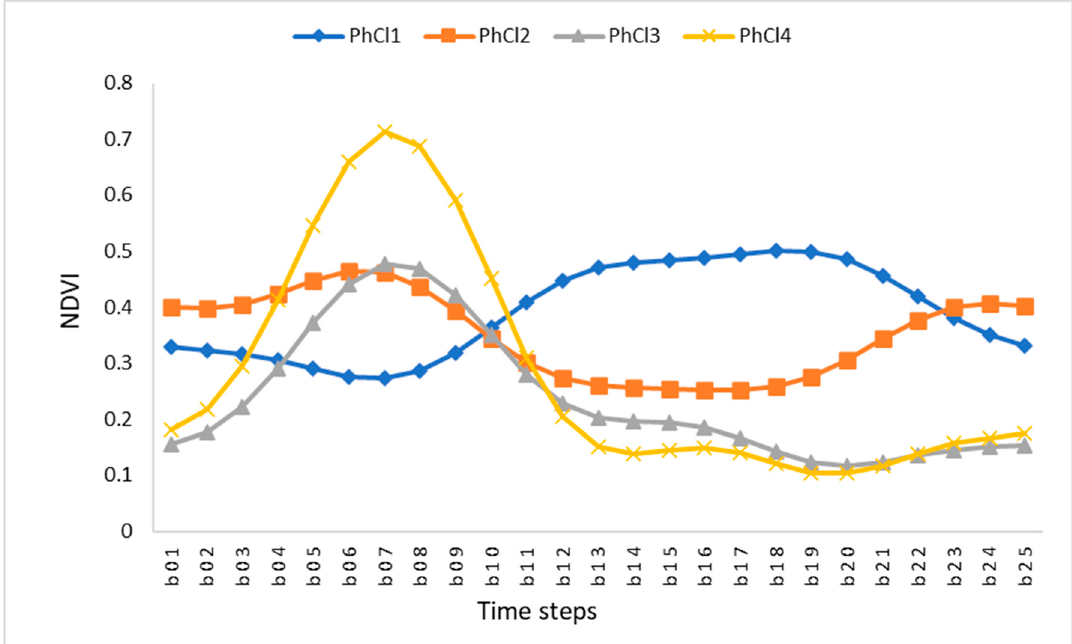
Figure 7. Mean NDVI profile of the four pheno-clusters (PhCls) identified.